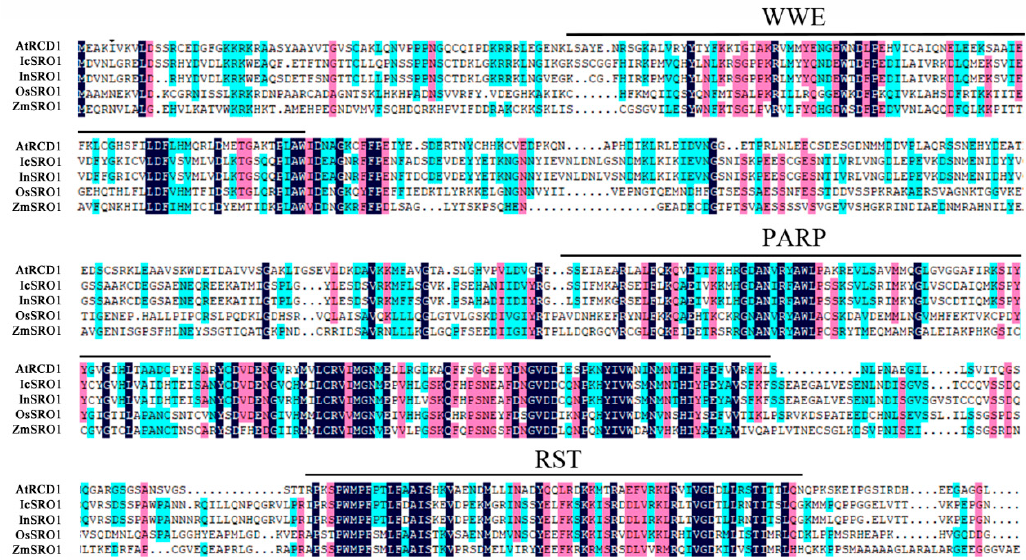
Figure 1. Sequence alignment of IcSRO1 with RCD1 from Arabidopsis thaliana and its homologies in Ipomoea batatas , Oryza sativa and Zeamays indicates that the amino acid sequence of IcSRO1 is similar to other species. N-terminal WWE domain, the core of the poly (ADP-ribose) polymerase (PARP), C-terminal RCD1-SRO-TAF4 domain (RST domain) are marked. Amino acid sequences of other genes were derived from NCBI (http://www.ncbi.nlm.nih.gov/).